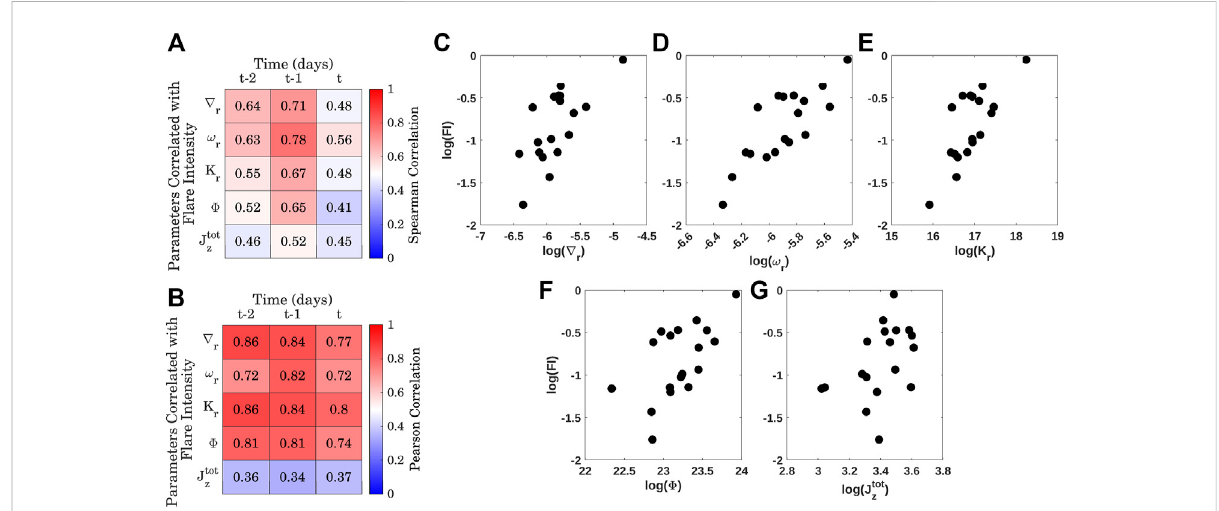
FIGURE 7 The integrated values of active region horizontal fl ow divergence ( ∇ r ), vertical vorticity ( ω r ), kinetic helicity (K r ), surface magnetic fi eld ( Φ ) and total unsigned photospheric current helicity ( J tot z ) obtained on t-2, t-1, and t days of fl are are correlated with integrated fl are intensity (FI). The fl ow parameters are averaged over 2 – 15.5 Mm. (A) Mean of Spearman correlation coef fi cients computed by removing the parameters corresponding to all unique permutations of 0 – 3elements fromthe18 fl aringactive regions. (B) Mean Pearsoncorrelationcoef fi cients computed as in (A) . Color bar represents the strength of correlations and the values > 0 . 4 have signi fi cance > 95 % . Scatter plot of integrated fl are intensity as a function